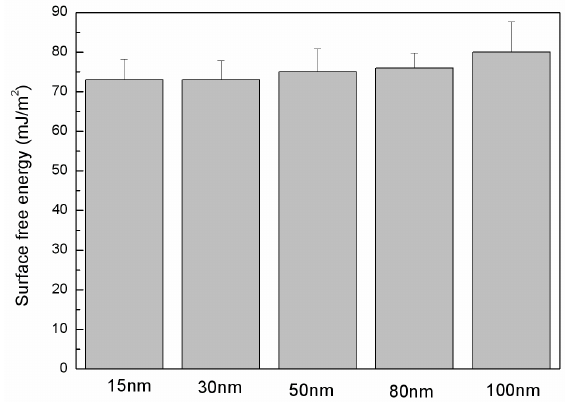
Figure 4. Values of surface free energy of the TNT samples after being sterilized in ethanol (mJ/m 2 ).